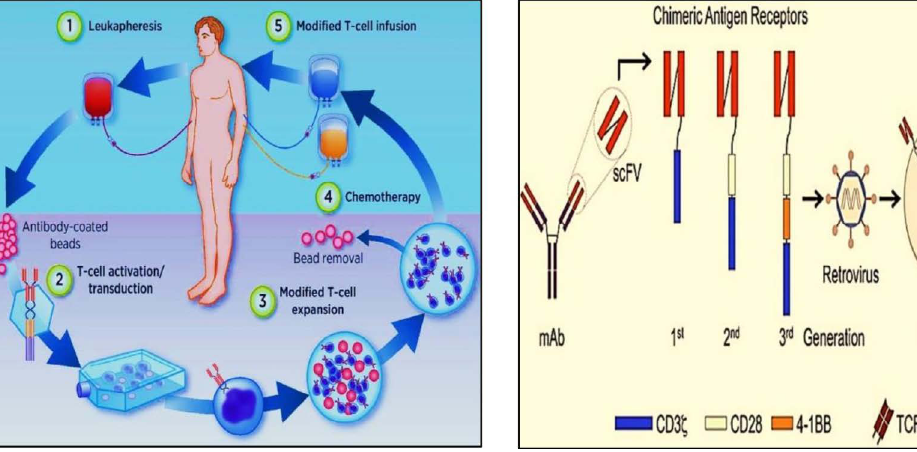
CART therapy CART therapy Fig. 3.1. Isolation of T cells from blood → transfection of T cells with genetically engineered viral vector → introduction of new gene to T cell → insertion of engineered T cells back to human host